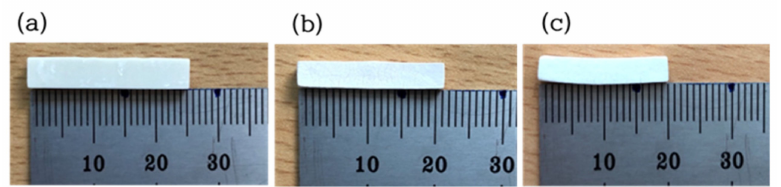
Figure 4. Photographs of the bodies in each stage: ( a ) green bodies, ( b ) debinded (6 h holding time) bodies, and ( c ) sintered bodies at 1300 ◦